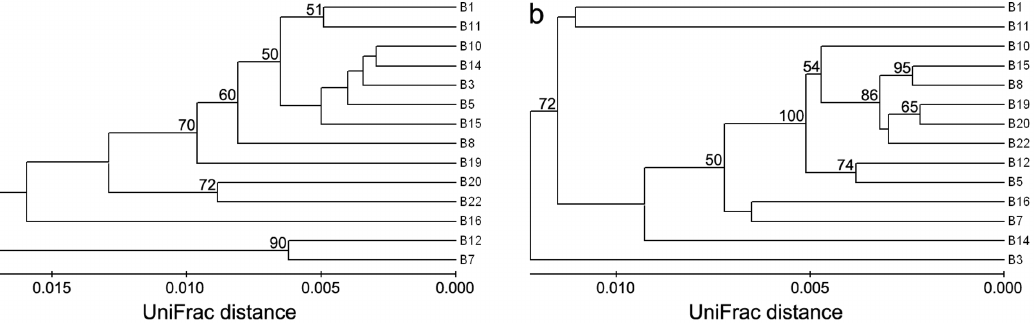
Figure 5. Dendrograms of hierarchical clustering analyses of the Bohai Sea sediment anammox bacterial assemblages. (a) Dendrogram of the hierarchical clustering analysis based on the Ca . Scalindua 16S rRNA gene sequences, and (b) dendrogram of the hierarchical clustering analysis based on the Hzo protein sequences. Both clustering dendrograms were obtained by using the Fast UniFrac normalized and weighted Jackknife Environment Clusters statistical method. The percentage supports of the classification tested with sequence jackknifing resamplings are shown near the corresponding nodes.